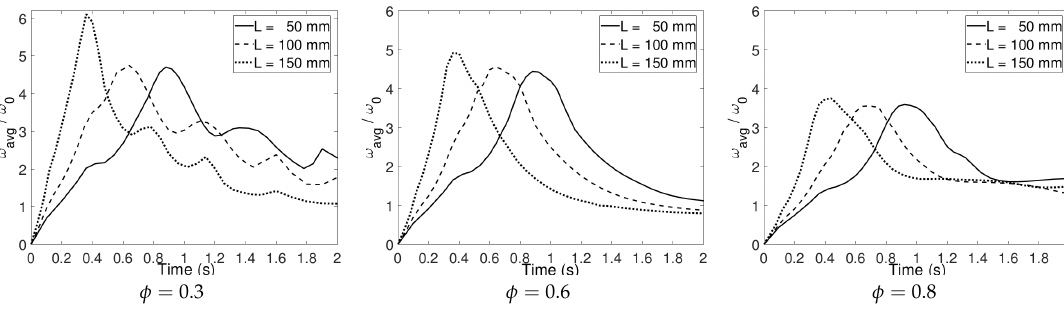
Figure 19. The effect of piston–screen distance on the average